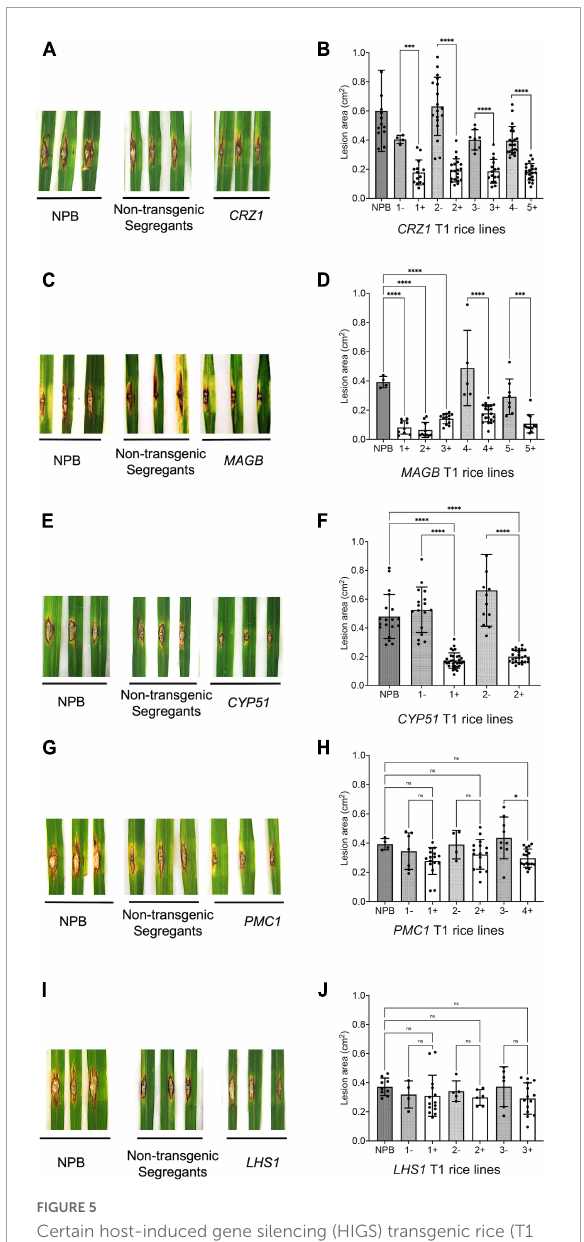
FIGURE5 Certain host-induced gene silencing (HIGS) transgenic rice (T1 generation) showed resistance to Magnaporthe oryzae . (A–J) Punch inoculation of HIGS transgenic rice plants targeting M. oryzae gene CRZ1 (A,B) , MAGB (C,D) , CYP51 (E,F) , PMC1 (G,H) and LHS1 (I,J) . Wild type Nipponbare (NPB) and non-transgenic segregants derived from corresponding T0 plants were used as negative control. Lesion area was measured and analyzed statistically (B,D,F,H,J) using multiple rice lines. The symbol “ + ” represents positive transgenic plants while “-” represents non-transgenic segregants. Ordinary one-way ANOVA and Turkey’s multiple comparison were used for statistics analysis. ∗ P < 0.0332, ∗∗∗ P < 0.0002, ∗∗∗∗ P < 0.0001, ns: not